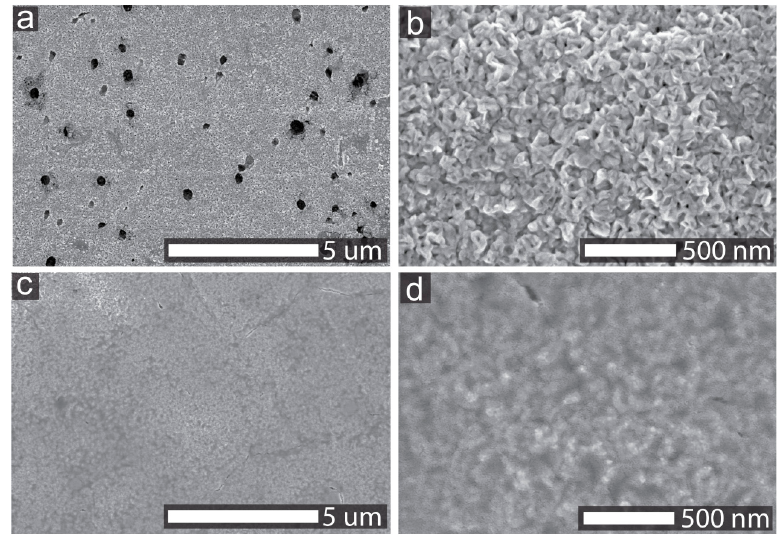
Figure 1. SEM images of NF/NiO ( a , b ) and Ni 95 Ce 5 O x ( c , d ) samples.